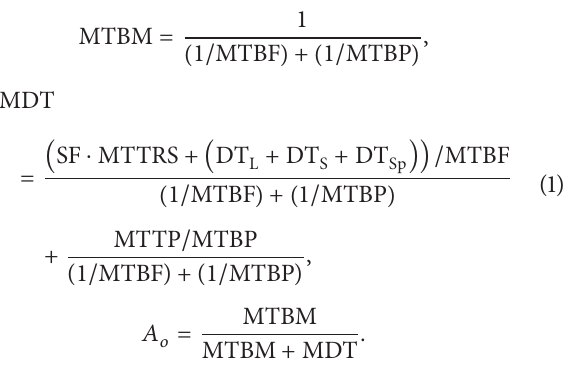
Table 2: Main technical parameters for the cost model from the RAM analysis.